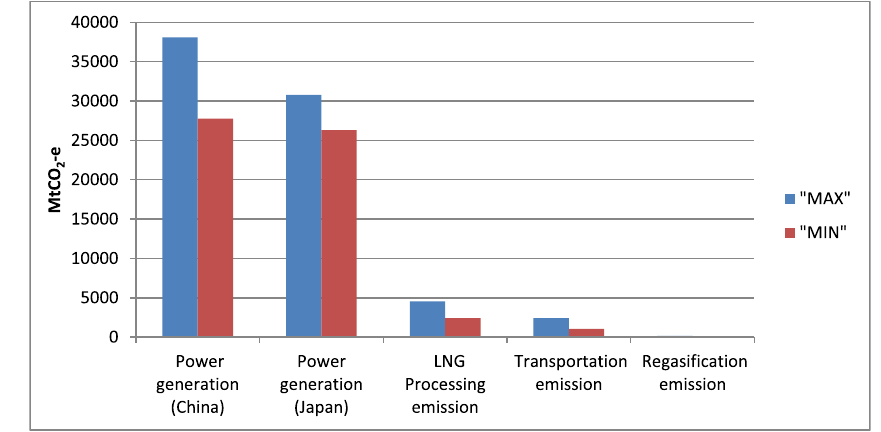
Fig. 5. End use emissions comparison for 235 tcf of shale gas.